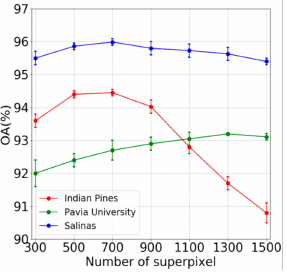
Figure 9. Changes of classification accuracy with the increase of the number of superpixels.